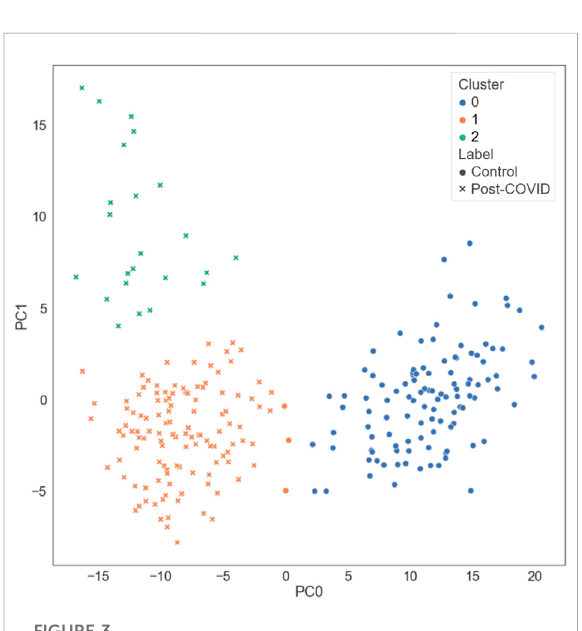
FIGURE 3 The distribution of the different types of subjects projected on the fi rst and the second principal